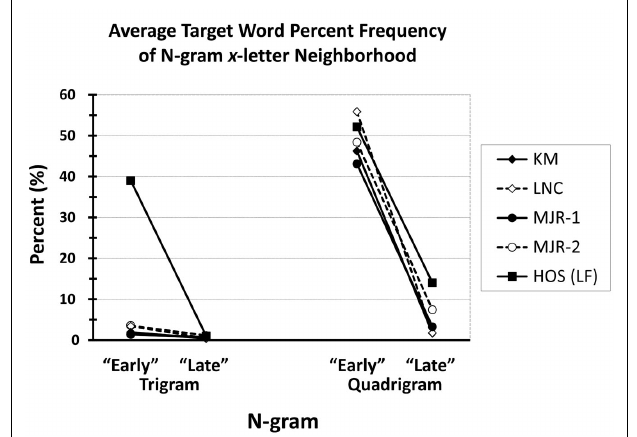
FIGURE 4 |Average percent frequency that target words represent of their trigram and quadrigram x -letter neighborhoods. KM, Kwantes and Mewhort (1999); LNC, Lindell et al. (2003); MJR-1, Experiment 1 of Miller et al. (2006); MJR-2, Experiment 2 of Miller et al.; HOS (LF), low frequency condition of the present study; “Early” and “Late” refer to Early OUP and Late OUP conditions in KM, LNC, MJR-1, and MJR-2, but to HC and LC conditions, respectively, in the present